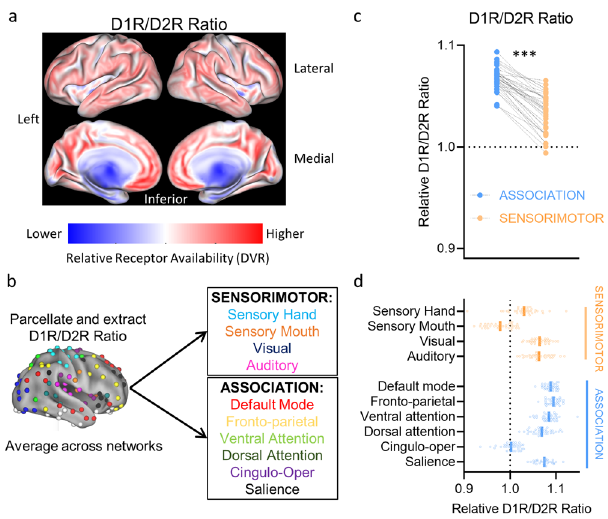
Fig. 2 Relative D1-D2 Ratio across the neocortex. a Relative (intensity- normalized) map of the ratio of dopamine D1-D2 receptor availability (relative D1R/D2R ratio). b Relative D1R/D2R ratio was extracted for each region of a 10-network parcellation, and averaged across all regions of each network. c The relative D1R/D2R ratio, for the average of all association and all sensorimotor networks. d The relative D1R/D2R ratio by individual networks (for visualization only). In panel c and d , each dot re fl ects a participant. In panel d , the solid lines represent the group mean for each network. Note: DVR = distribution volume ratios. *** p < 0.001. Brain image in panel b is reprinted from Neuron, 72(4), Power, J.D., Cohen, A.L., Nelson,